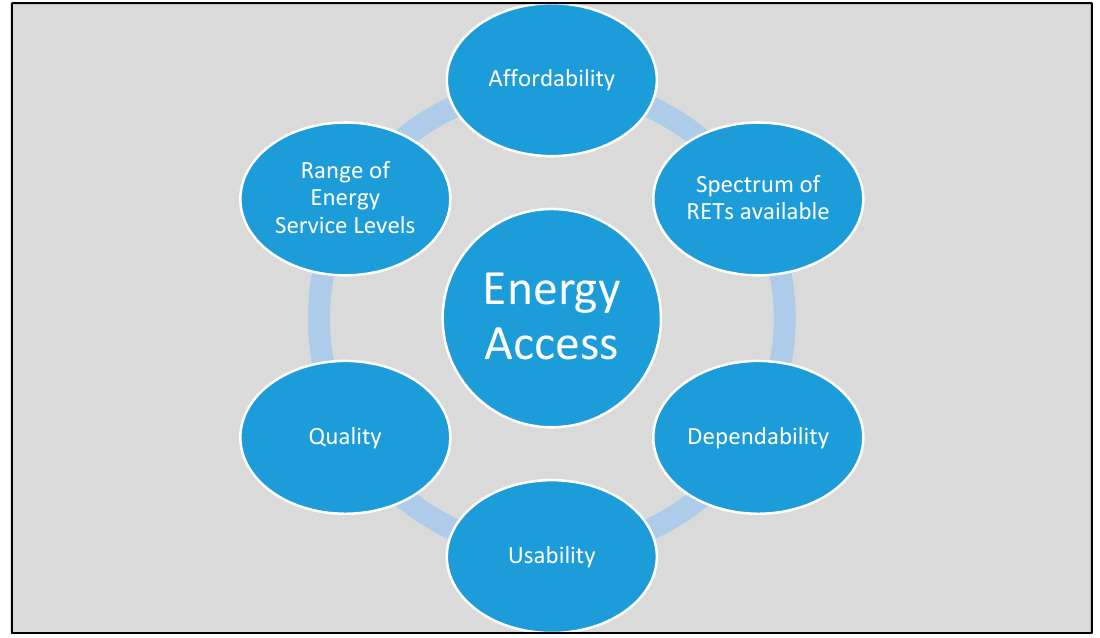
Figure 2. Adapted from Avila et al. [14], this graphical representation demonstrates the various facets of renewable energy access.